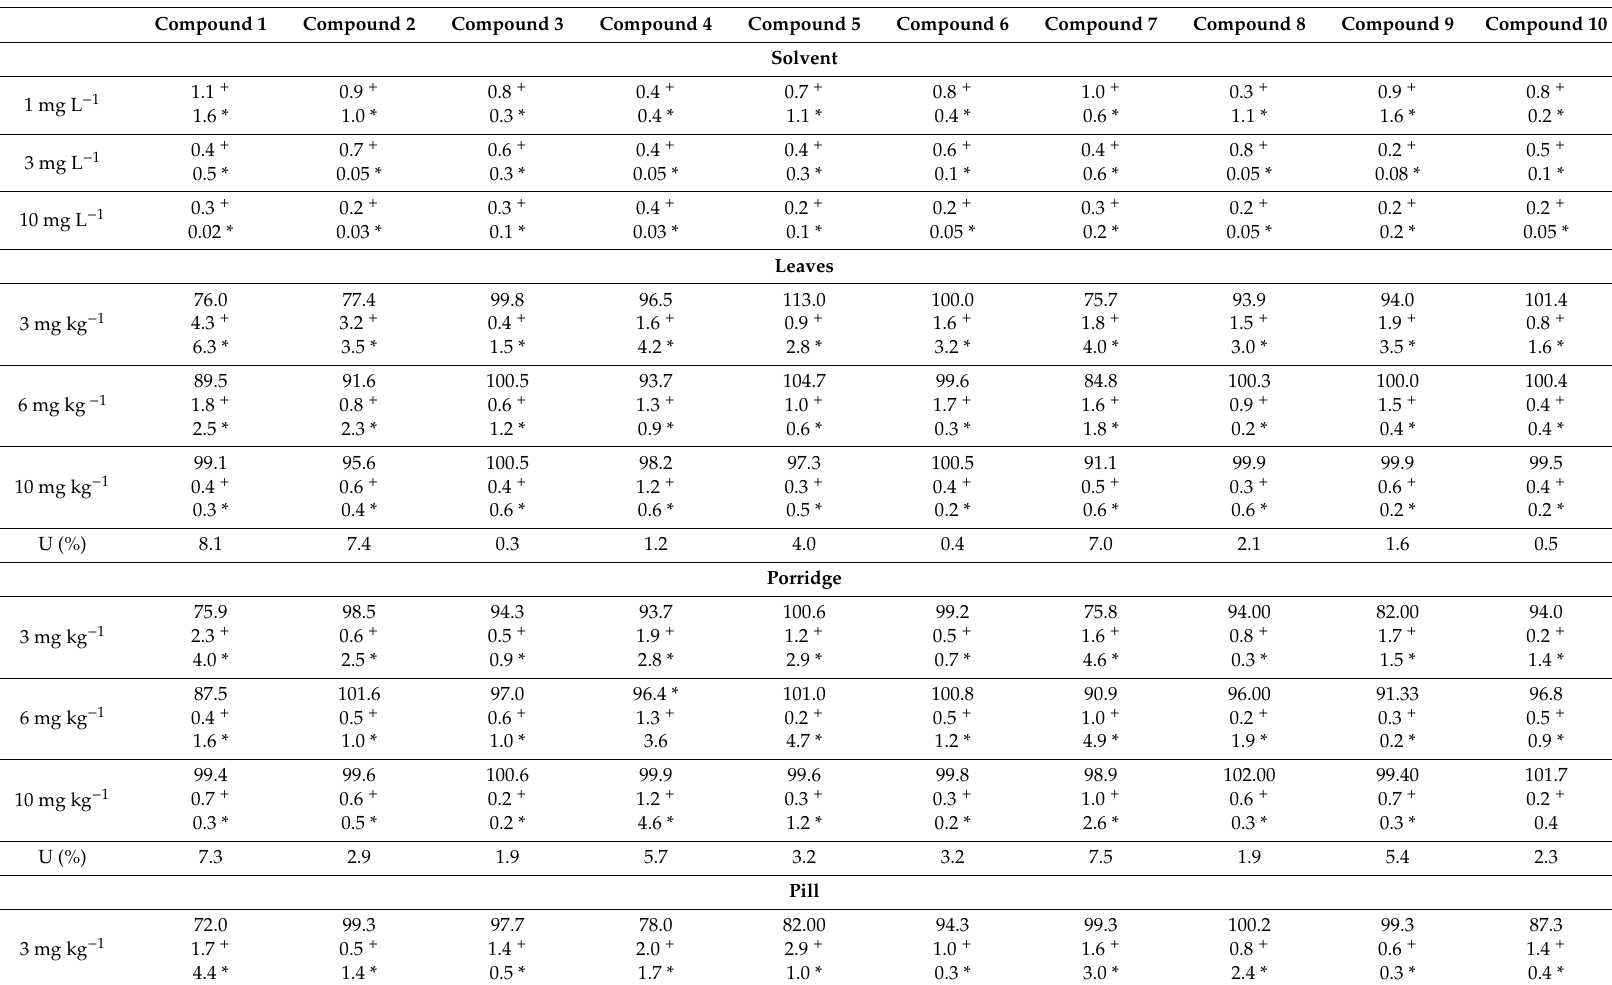
Table 2. Percentage recoveries, (percentage relative standard deviation (%RSD)) Intra-day + , (%RSD) Inter-day *, and measurement uncertainty for the compounds in the solvent and di ff erent